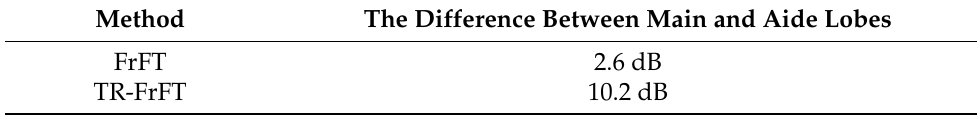
Figure 13. The result of received signal processed by TR-FrFT with lake experiments data. Table 6. The comparison results of FrFT and TR-FrFT with lake experiments